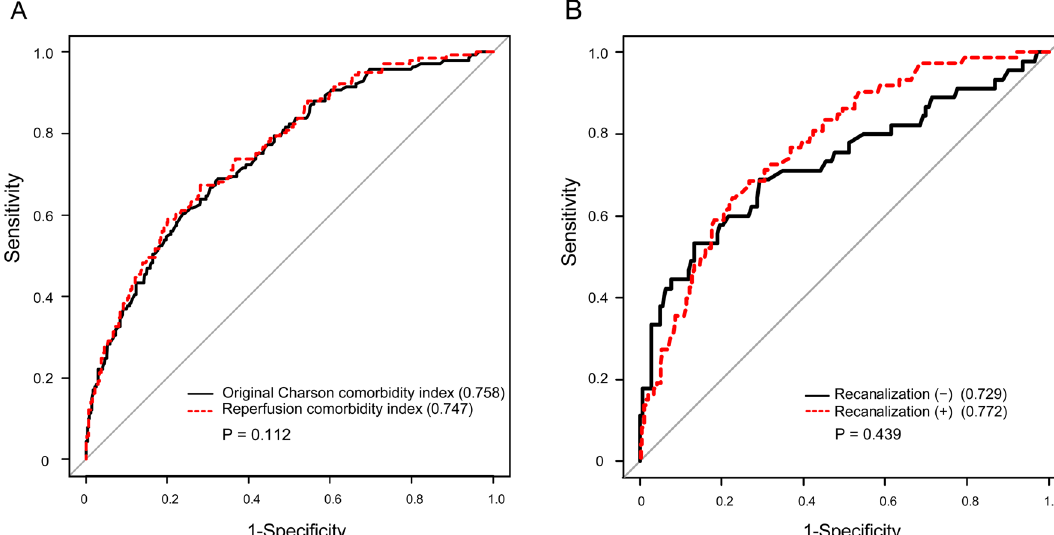
Figure 4. Receiver-operating characteristic curve (ROC) comparison death within 6 months mortality according to two models ( A ) and achievement of recanalization ( B ). ROC comparison for death within 6 months showed that the area under the curve (AUC) did `not differ between reperfusion comorbidity index (age + 6 comorbidities [myocardial infarction, congestive heart failure, ulcer disease, diabetes mellitus, anemia, and metastatic cancer]) and the original Charlson comorbidity index model (age + 16 comorbidities) ( p = 0.112) ( A ). ROC curve comparison showed that the AUC did not differ according to recanalization status ( p = 0.439) ( B